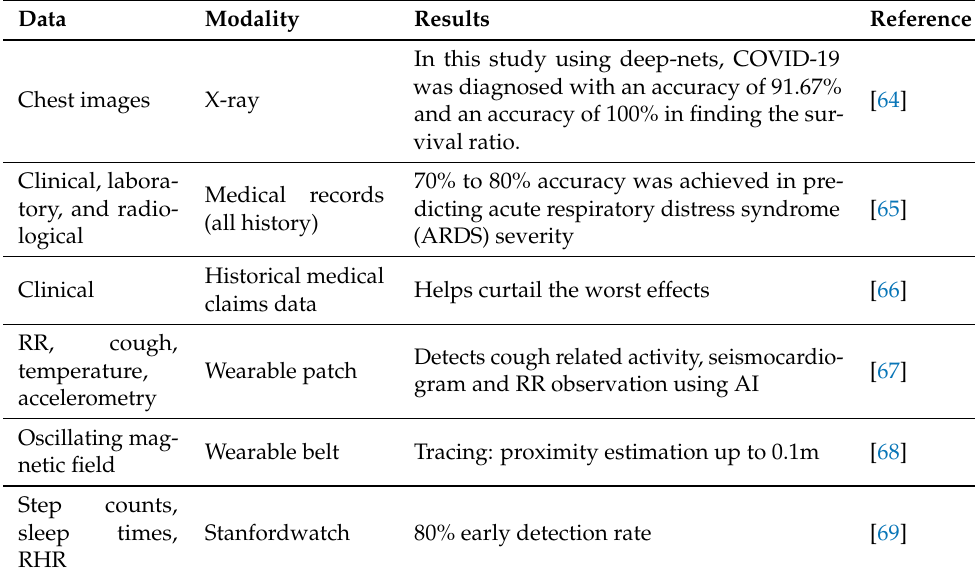
Table 2. Summary of some research studies that used AI technology in the diagnosis and prevention of